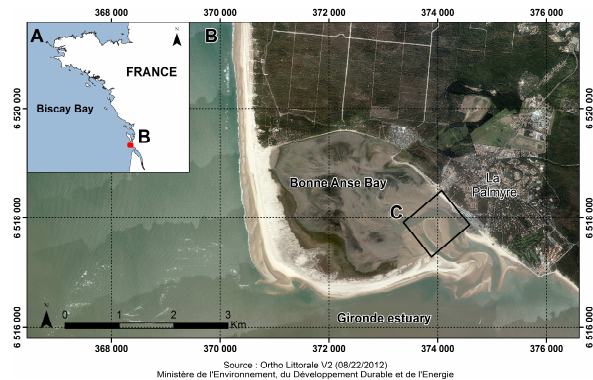
Figure 1. Location of the study area (A) on the Atlantic coast of France, (B) the Bonne-Anse lagoon and (C) the study area (coordinates : Lambert 93 projection)